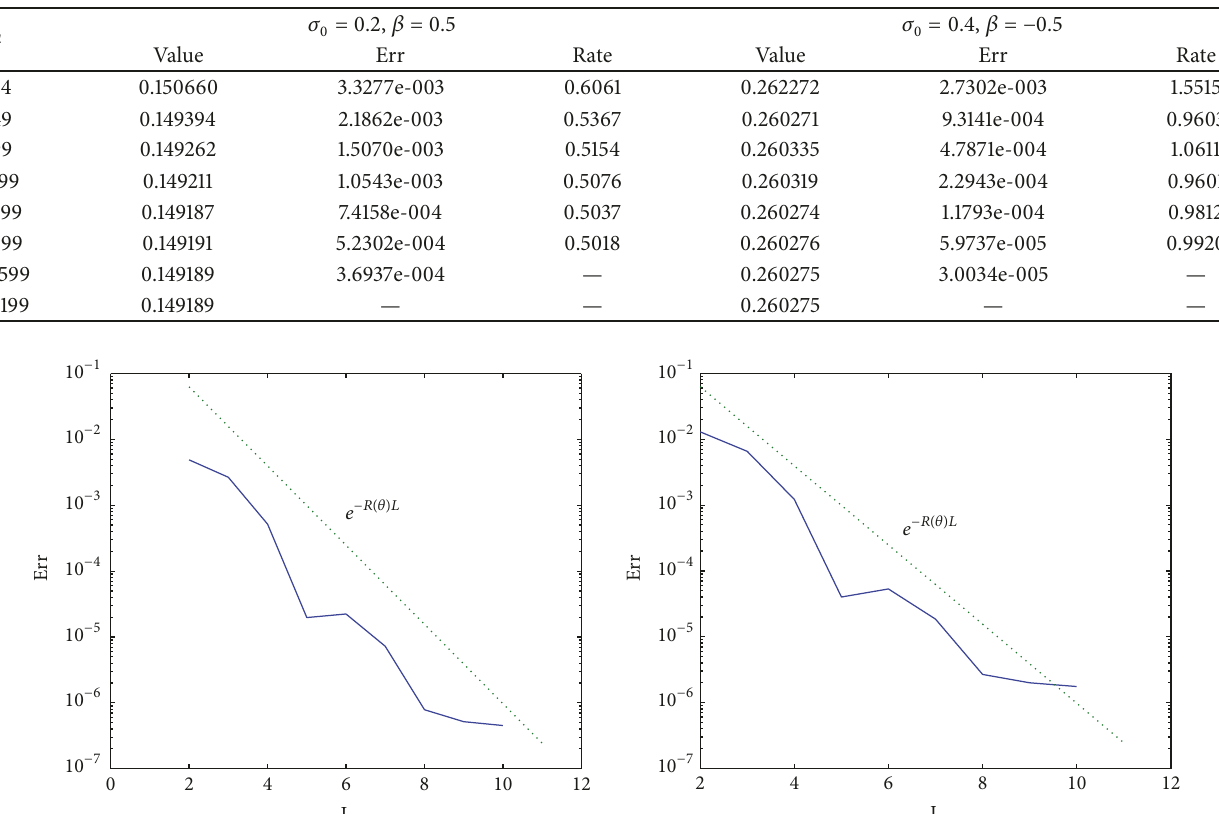
Figure 1: LTM-HCIM errors in log-scale v.s. 𝐿 for American CEV Strangles option at 𝜏 = 1 . Left: log scale errors with 𝜎 0 = 0.2 , 𝛽 = 0.5 ; Right: log scale errors with 𝜎 0 = 0.4 , 𝛽 = −0.5